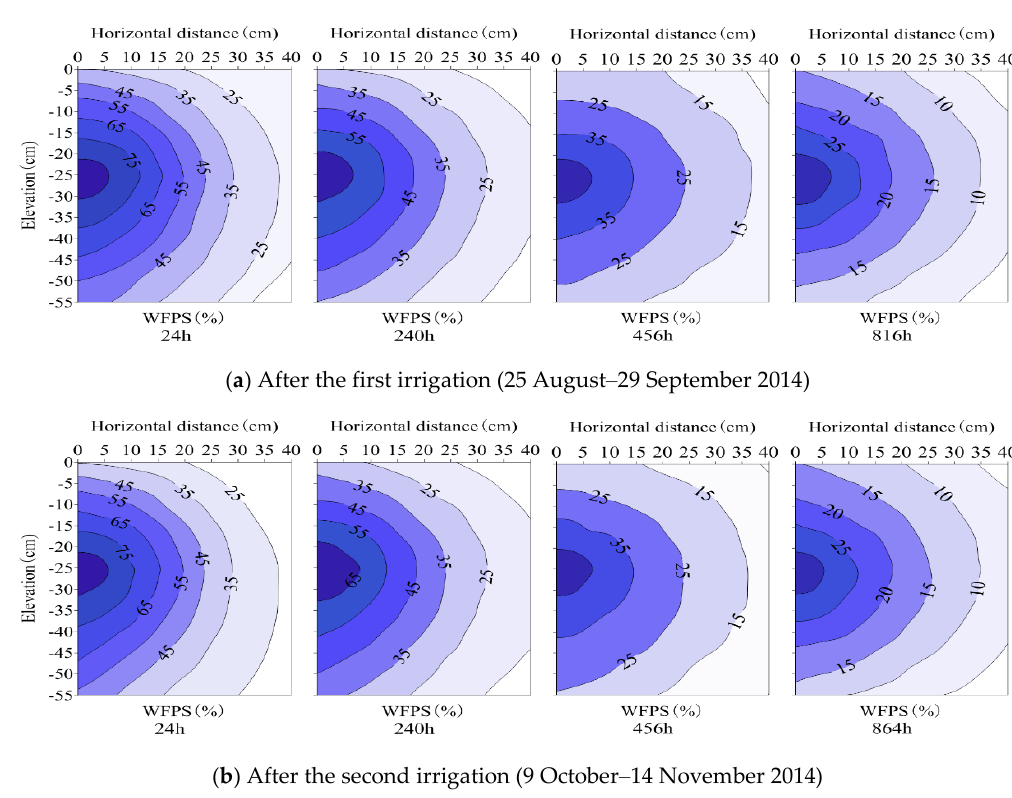
Figure 4. Soil moisture distribution in SDI–2 treatment (surface soil wetting proportion is 10.9%).